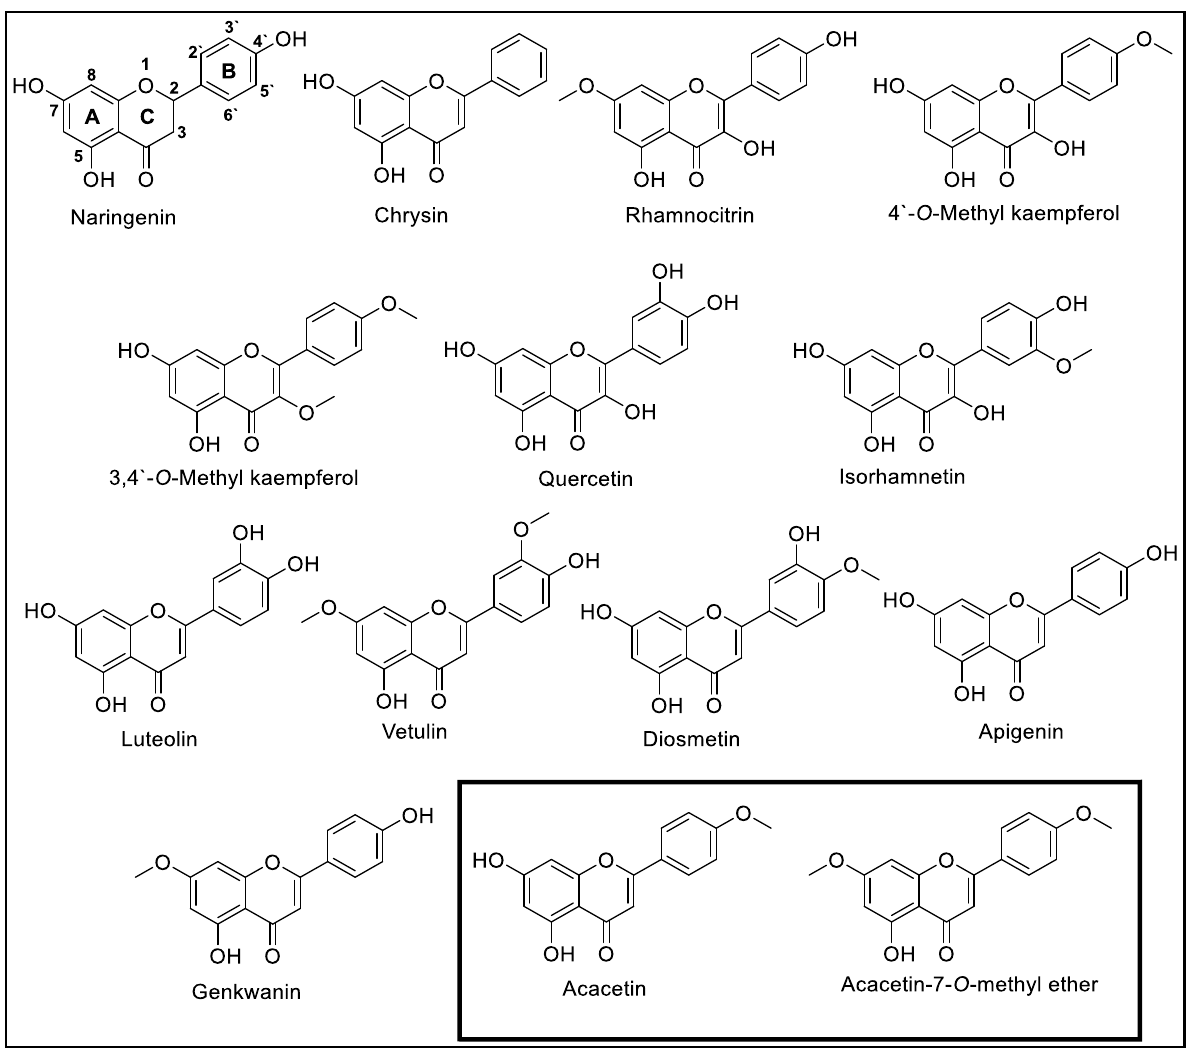
Figure 1. Comparison of acacetin and acacetin 7- O -methyl ether with known flavonoids. Table 1. Comparison of the IC 50 values of acacetin and acacetin 7-O-methyl ether with known fla- vonoids.